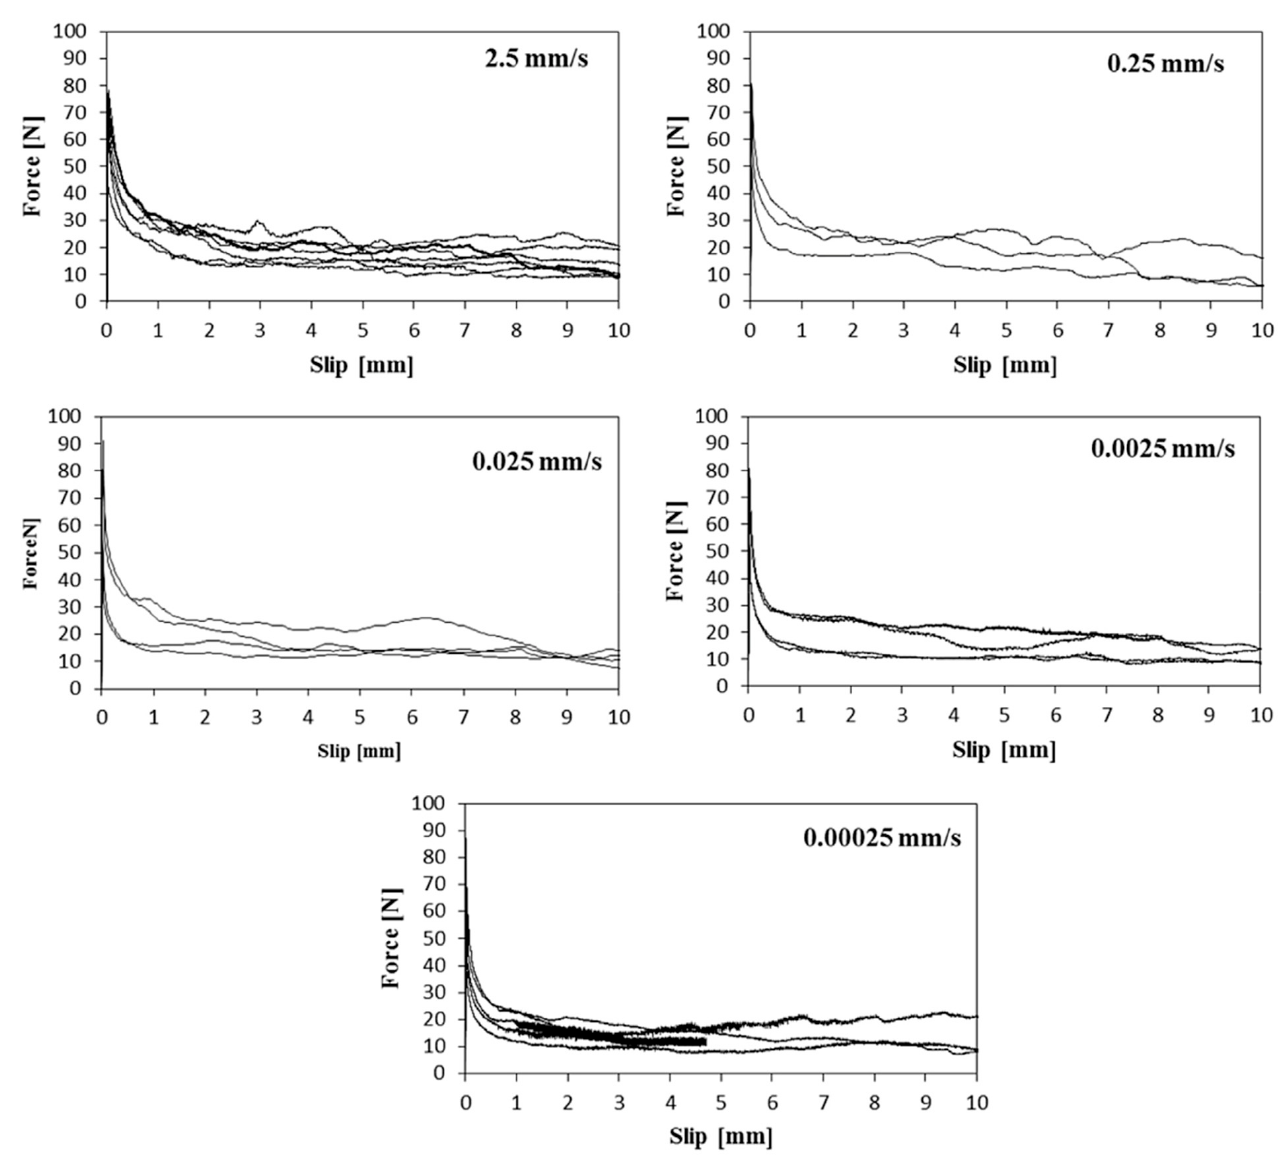
Figure 15. The single fibre pull-out test results on straight fibres [101]. Figures 18–20 depict the findings of their research. The results of the experiments for four different inclination angles with three loading rates on the pull-out load vs. slip curves of the S, H, and T specimens are presented. At least three specimens were used to average the curves for each pair. The pull-out behaviour of aligned S fibres differed from that of inclined S fibres, as shown in Figure 18. This may be directly due to the processes discussed previously. It is also evident, from Figure 18, that hardening arose at all the inclination angles and that the loading rate sensitivity is essential. However, in the H and T fibres, the effects of the loading rate and fibre inclination were not noticeable, as shown in Figure 19 and Figure 20, respectively. According to previous studies, the maximum pull-out load increases to an inclination angle of 30–45 ◦ before declining at 60 ◦ and beyond [27]. At a quasi-static loading rate (0.018 mm/s), the S fibres in their study adhered to this pattern, with the highest peak pull-out load (65.8 N) observed at a 45 ◦ inclination angle. The H and T fibres had slightly diverse patterns. At the inclination angles of 30 ◦ and 15 ◦ , the highest peak pull-out loads at the quasi-static loading rate were recorded as 229.2 N and 303.9 N, correspondingly. After the pull-out, the hooks of H fibres were straightened entirely